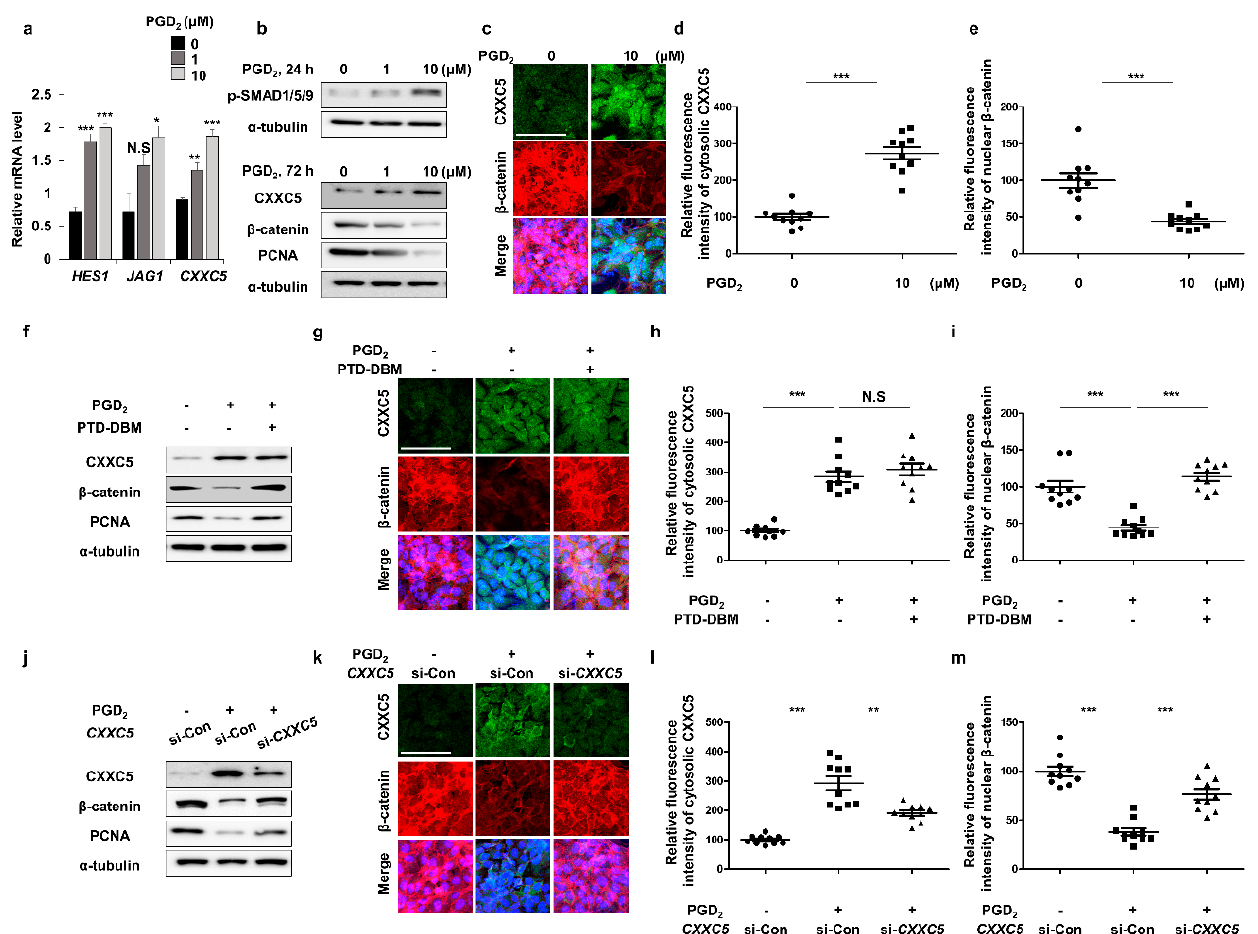
Figure 2. Effects of PGD 2 and PTD-DBM on hair markers. ( a – e ) HaCaT cell lines were incubated